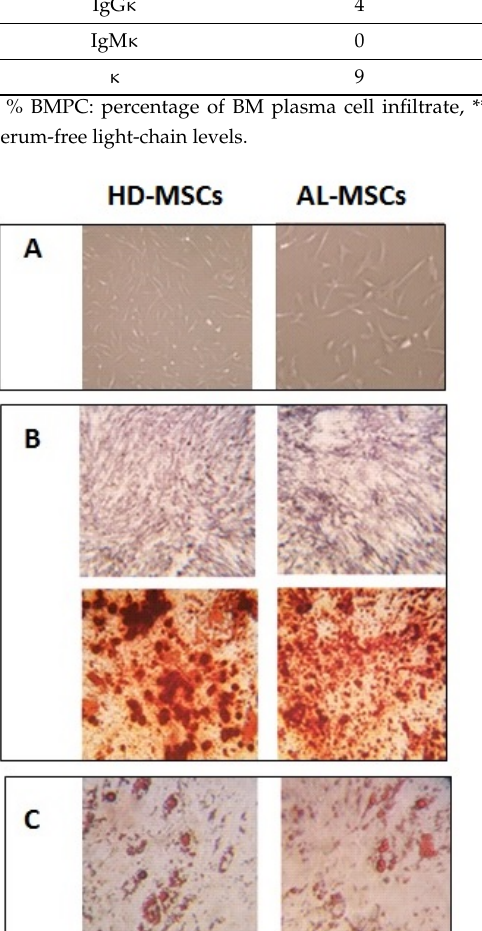
Figure 1. Morphology and differentiation capacity of AL-compared to HD-MSCs. ( A ) Typical spindle shape morphology of plastic adherent MSCs (4×). ( B ) In vitro-induced osteogenic differentiation demonstrated by the detection of phosphatase alkaline activity stained in blue/violet by BCIP/NBT and calcium deposition stained by Alizarin Red S (4×). ( C ) In vitro-induced adipogenic differentiation demonstrated by the appearance of lipid droplets stained by Oil red O (4×). As HD-MSCs, AL-MSCs expressed >95% of CD90, CD73, CD105, and HLA-I surface antigens, and ≤ 5% of CD34, CD45, CD14, and CD31 molecules (Figure 2).